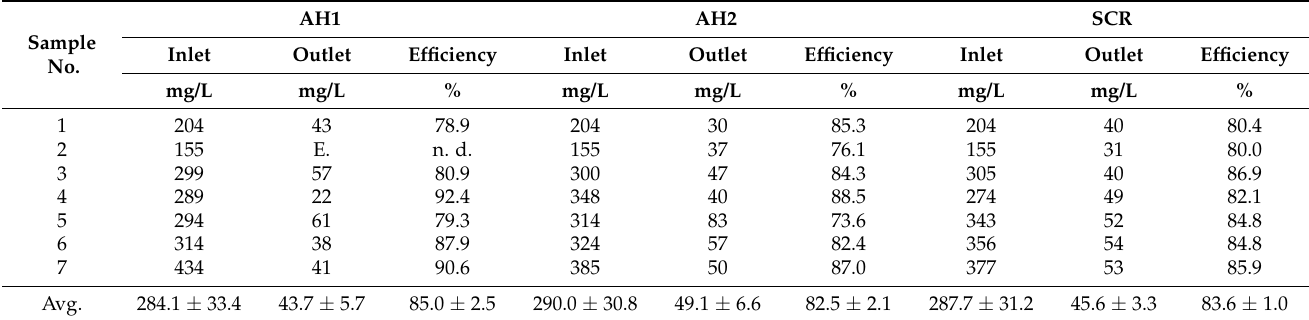
Table 2. Inlet and outlet COD and removal efficiencies at stage